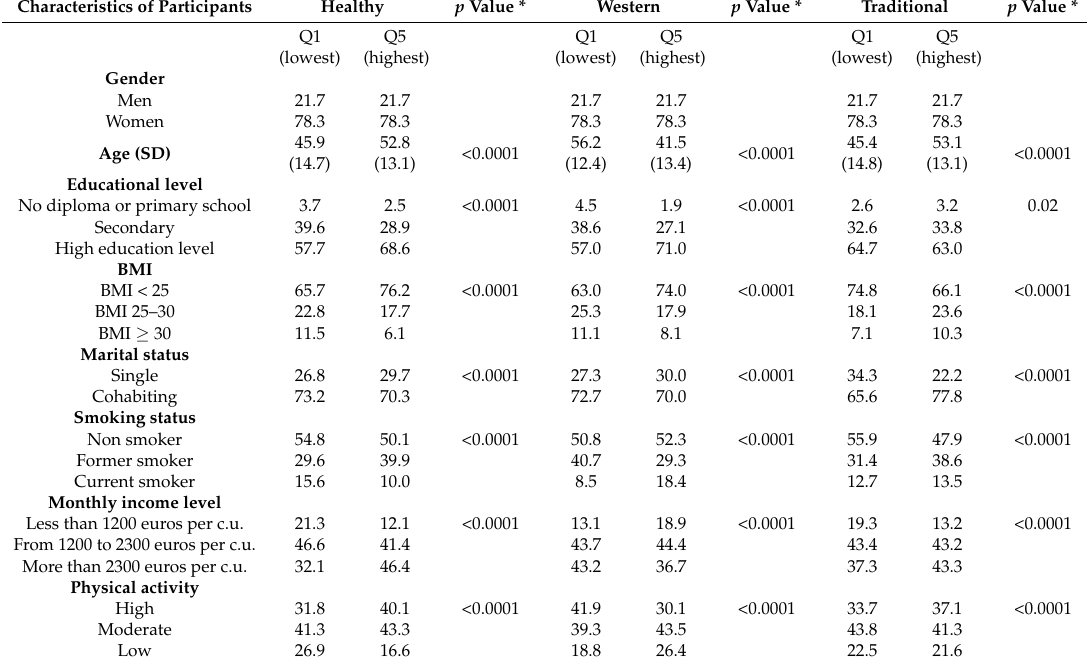
Table 3. Characteristics of participants by quintiles (Q) categories of dietary pattern scores ( n = 44,350). Characteristics of Participants Healthy p Value * Western